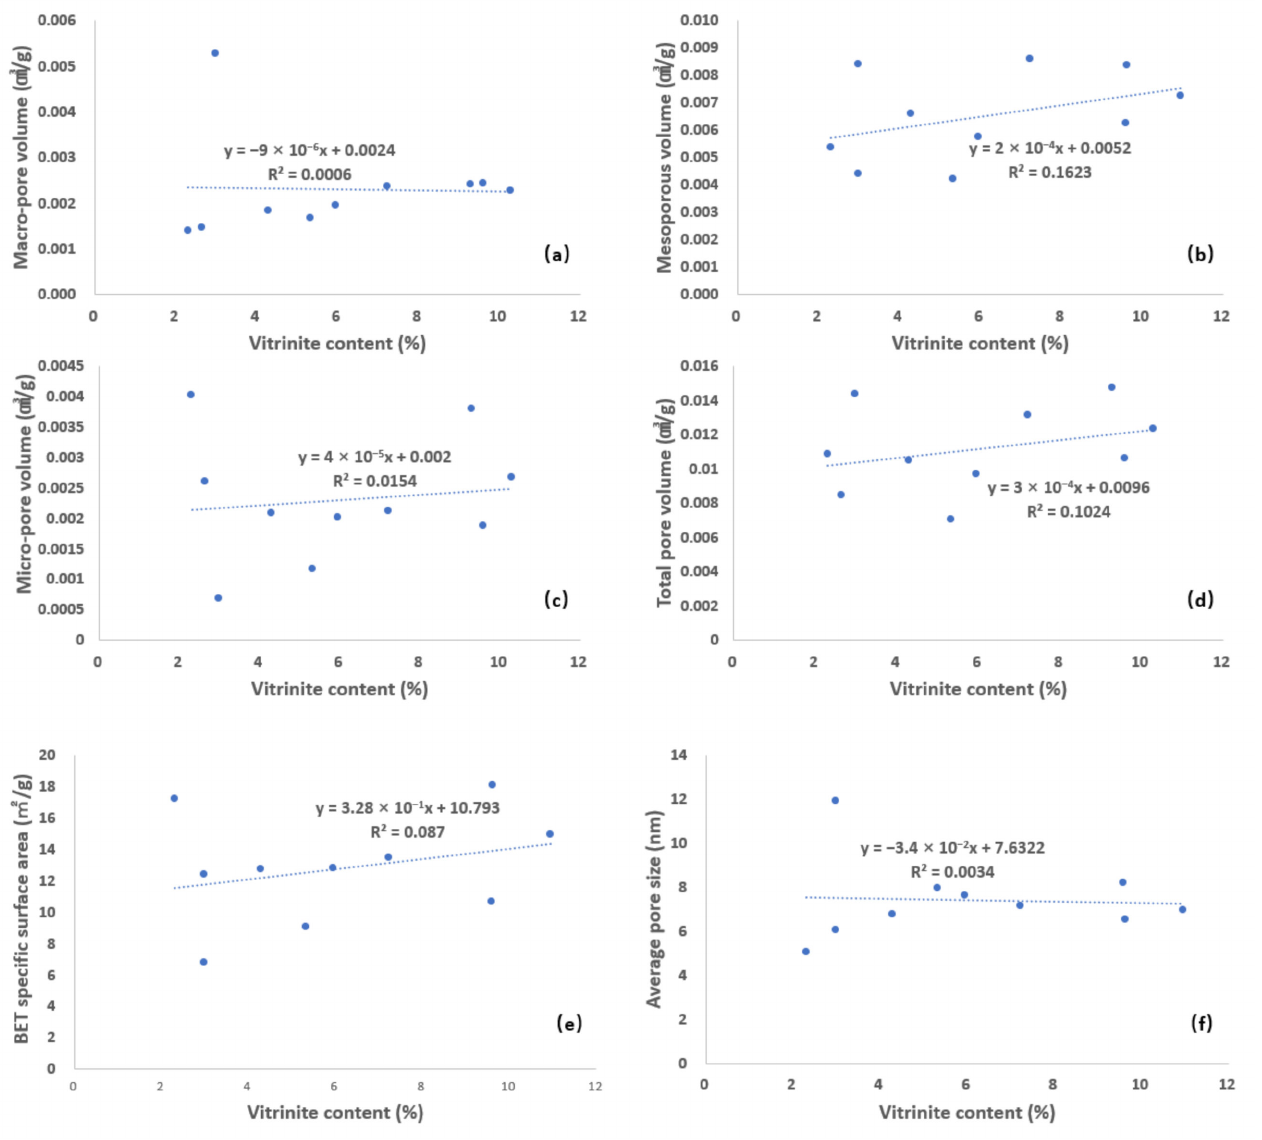
Figure 9. Relationship between microscopic pores and vitrinite content of lower Cambrian black shale from the Niutitang formation in Wenshuicun section, Guizhou province; ( a ) the cross plot of macropore volume and vitrinite content; ( b ) the cross plot of mesoporous volume and vitrinite content; ( c ) the cross plot of micropore volume and vitrinite content; ( d ) the cross plot of total pore volume and vitrinite content; ( e ) the cross plot of BET specific surface area and vitrinite content; ( f ) the cross plot of average pore size and vitrinite